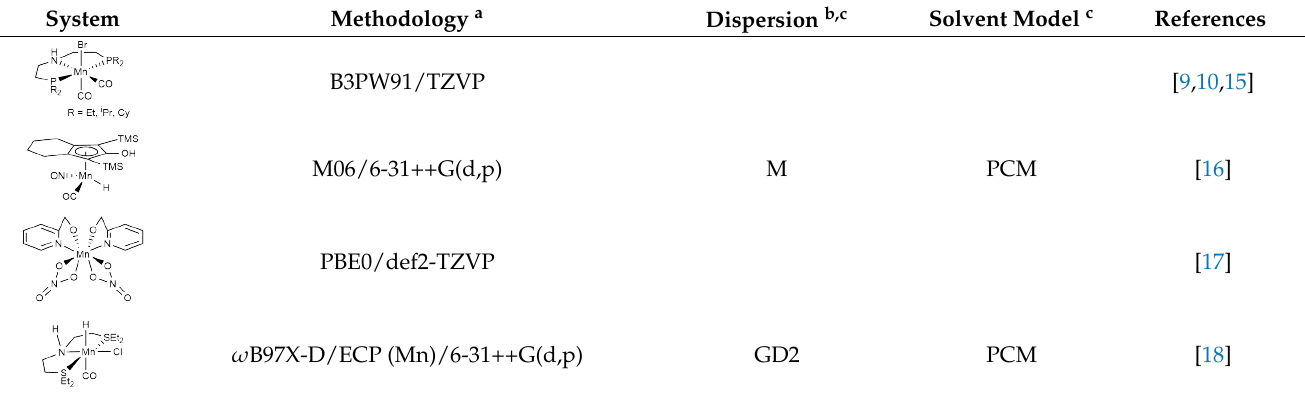
Table 1. A summary of the literature methodology used for DFT calculations on 3d metal catalytic systems.